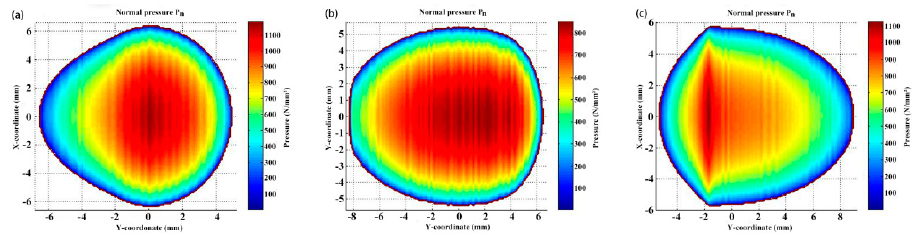
Figure 19. LMa matching CHN60. ( a ) Lateral displacement 0 mm; ( b ) Lateral displacement 3 mm; ( c ) Lateral displacement 6 mm.